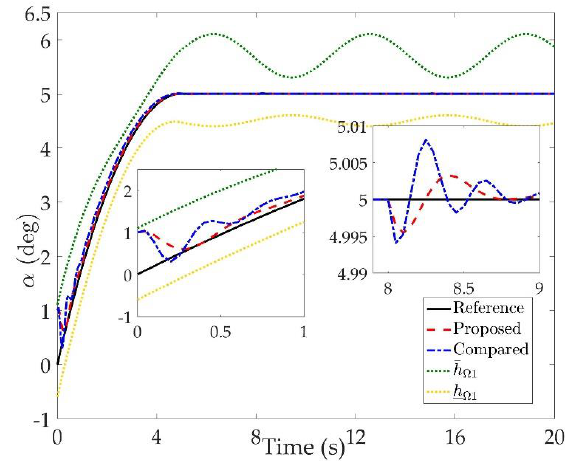
Figure 2. Comparison curves of the angle of attack α tracking